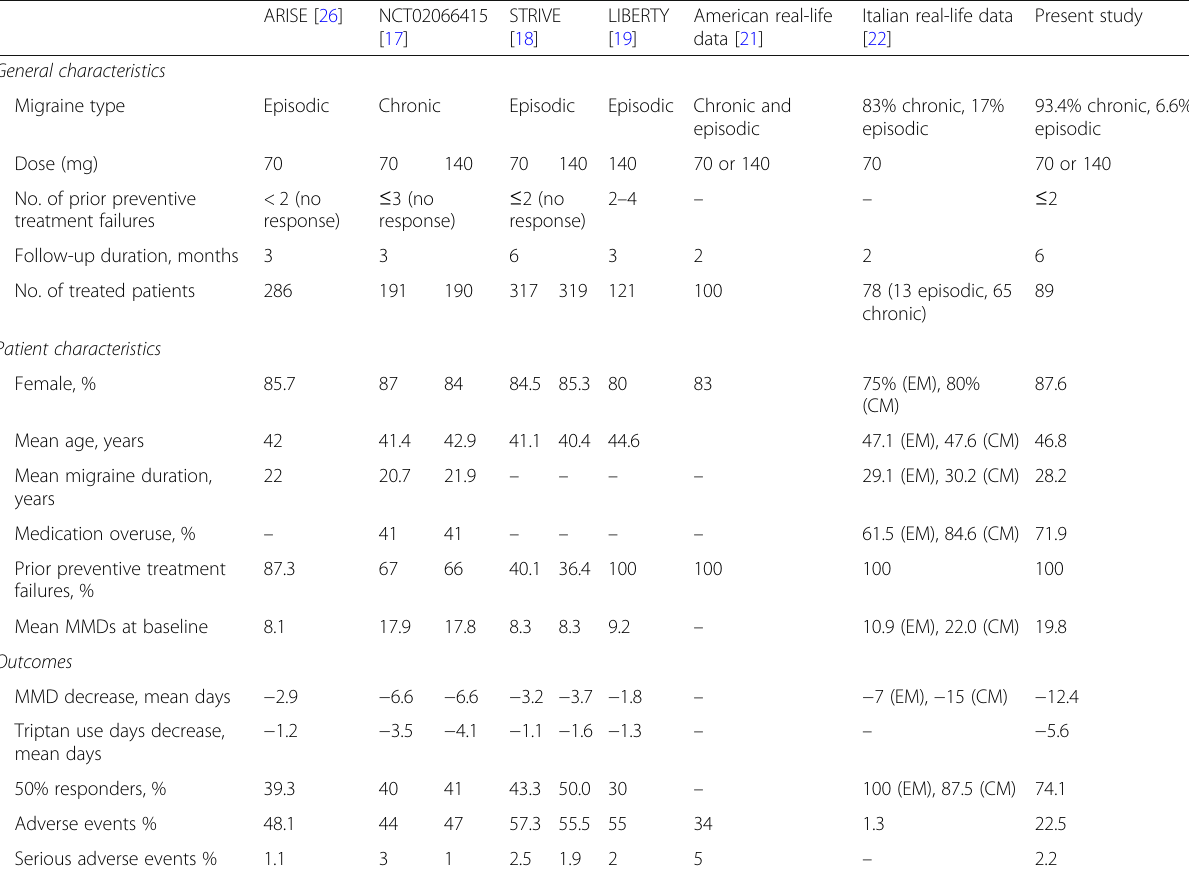
Table 5 Comparison between the randomized controlled trials of erenumab for the prevention of migraine and the present